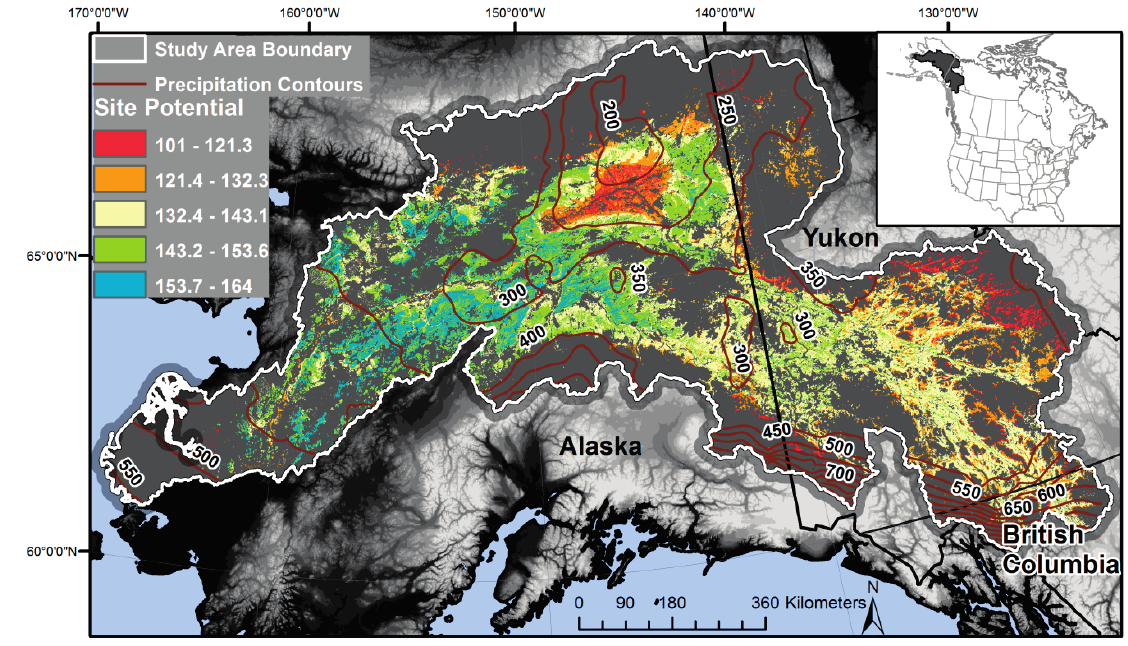
Figure 1. Site potential productivity of boreal forest determined from a regression tree model of topographic, edaphic, ecological, and climate inputs in the Yukon River Basin. Total yearly precipitation contours (50 mm intervals) are denoted by the maroon lines. Background shading depicts elevation ranging from low (black) to high (white), only visible for non-modeled areas. Inset map shows the location of the study area, shaded grey, within North